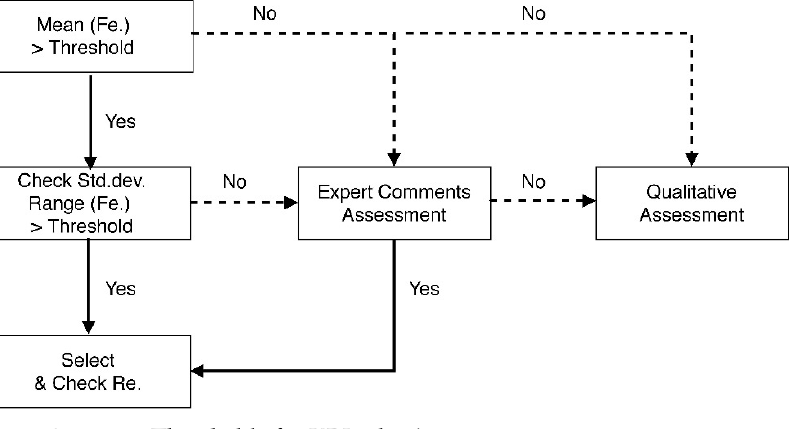
Thresholds for KPI